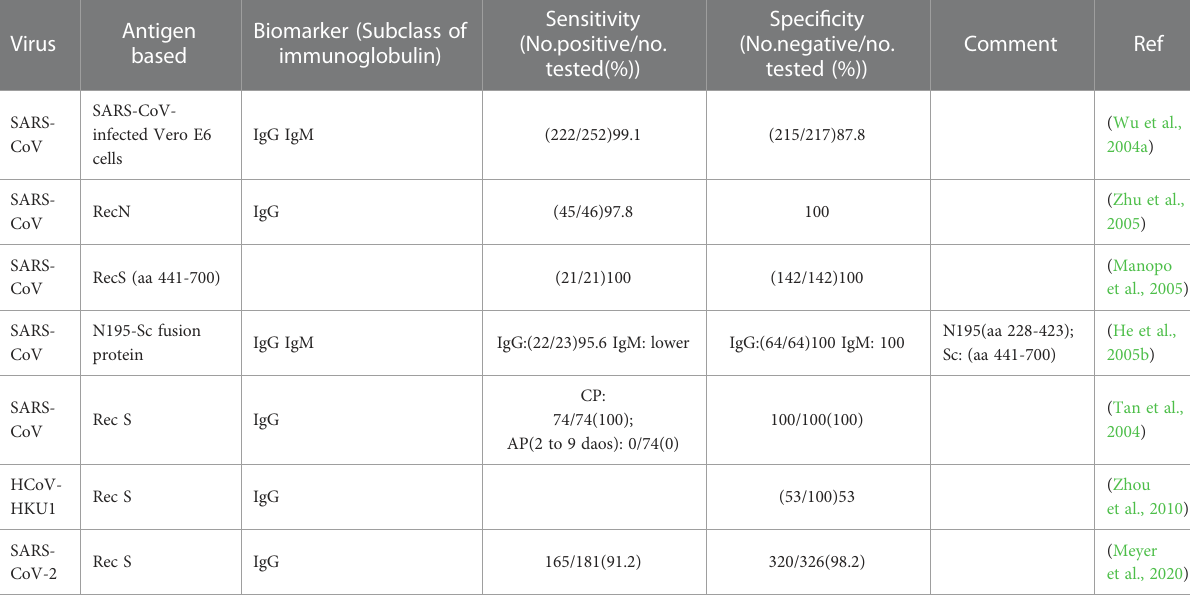
TABLE 5 IFA for antibody detection validated by clinical samples.